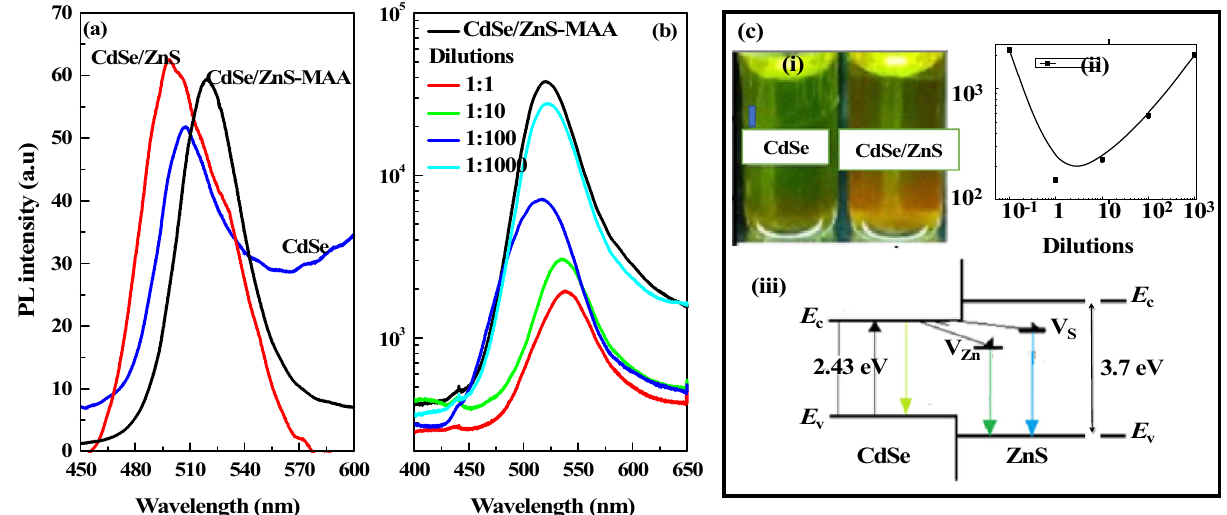
Figure 2. ( a ) Photoluminescence spectra of CdSe (blue color), CdSe/ZnS (red color) and CdSe/ZnS-MAA (black color). The inset shows a luminescence image of Left: CdSe QDs and Right: band diagram of CdSe/ZnS QDs. ( b ) The PL spectra of MAA-QDs (black color) after conjugation with different dilutions of COx: 1:1 (red), 1:10 (blue), 1:100 (green), and 1:1000 dilution (pink) COx conjugated QDs. ( c ) (i) The fluorescence images of CdSe (left) and CdSe/ZnS (right); (ii) plot of variation in the integrated intensities as a function of dilution; and (iii) the energy band diagram of CdSe/ZnS heterostructure with possible optical transitions from V Zn and V S